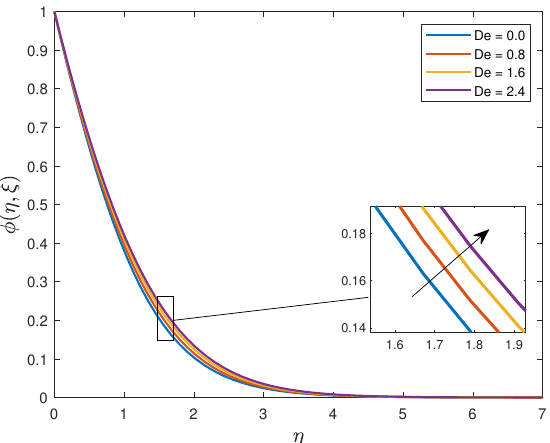
Figure 15. The influence of De on fluid concentration.